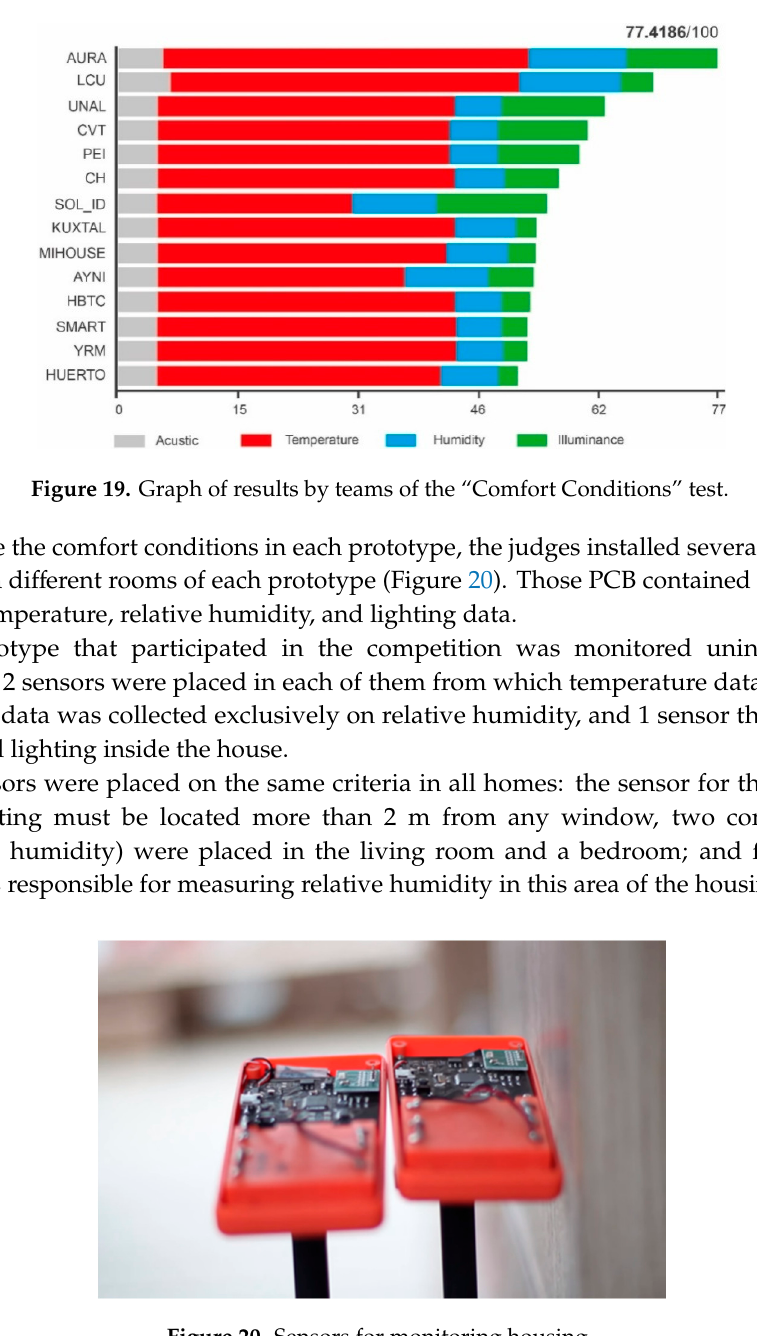
Figure 18. Image of one of the solar reflectors.